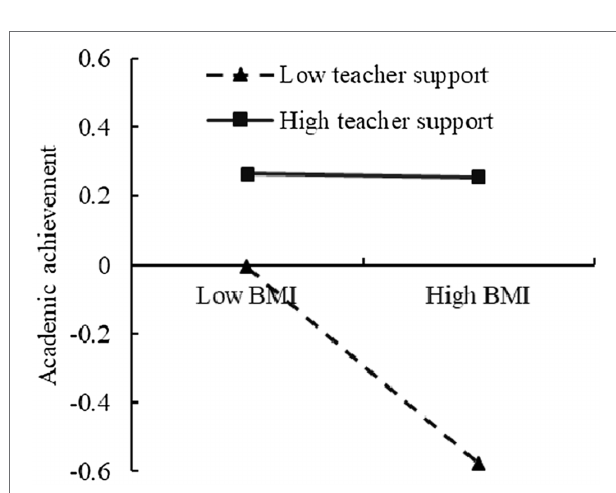
FIGURE 5 | The moderating effect of the teacher support on the relationship between BMI and academic achievement.